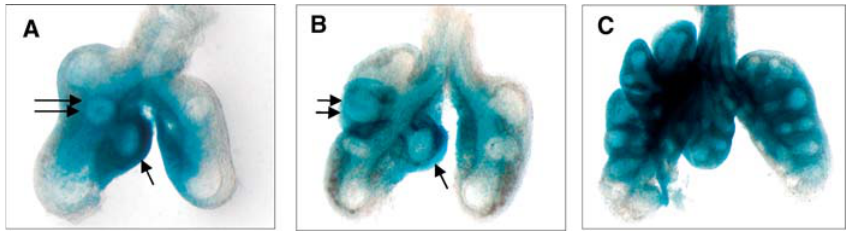
Figure 5. Fog2 Expression in Embryonic Non-Mutant Lungs In embryonic non-mutant lungs, Fog2 is most highly expressed at the tips of the accessory (single arrows) and right middle lobes (double arrows) at E11.25 (A) and E11.75 (B), while expression is diffuse by E12.75 (C). DOI: 10.1371/journal.pgen.0010010.g005